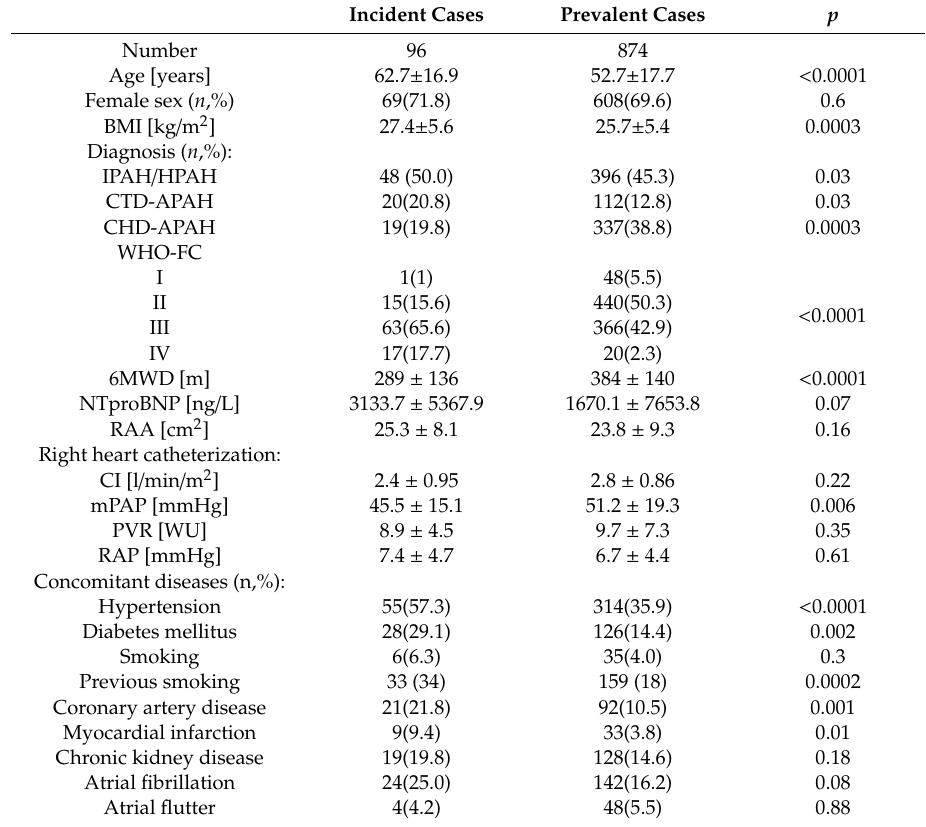
Table 6. Comparison of incident and prevalent patients with pulmonary arterial